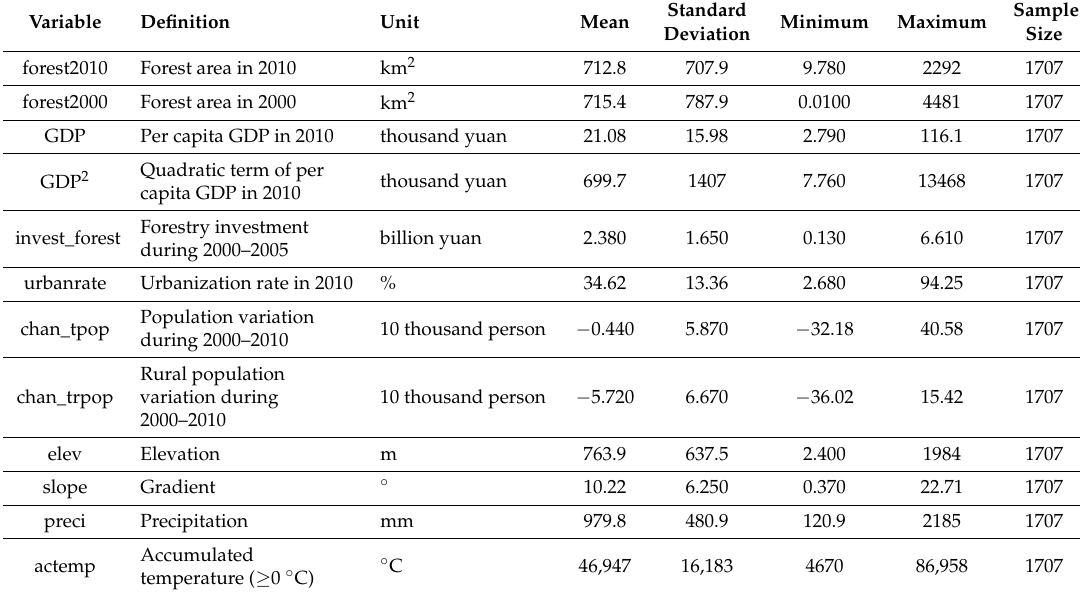
Table 1. Definitions and statistical descriptions of